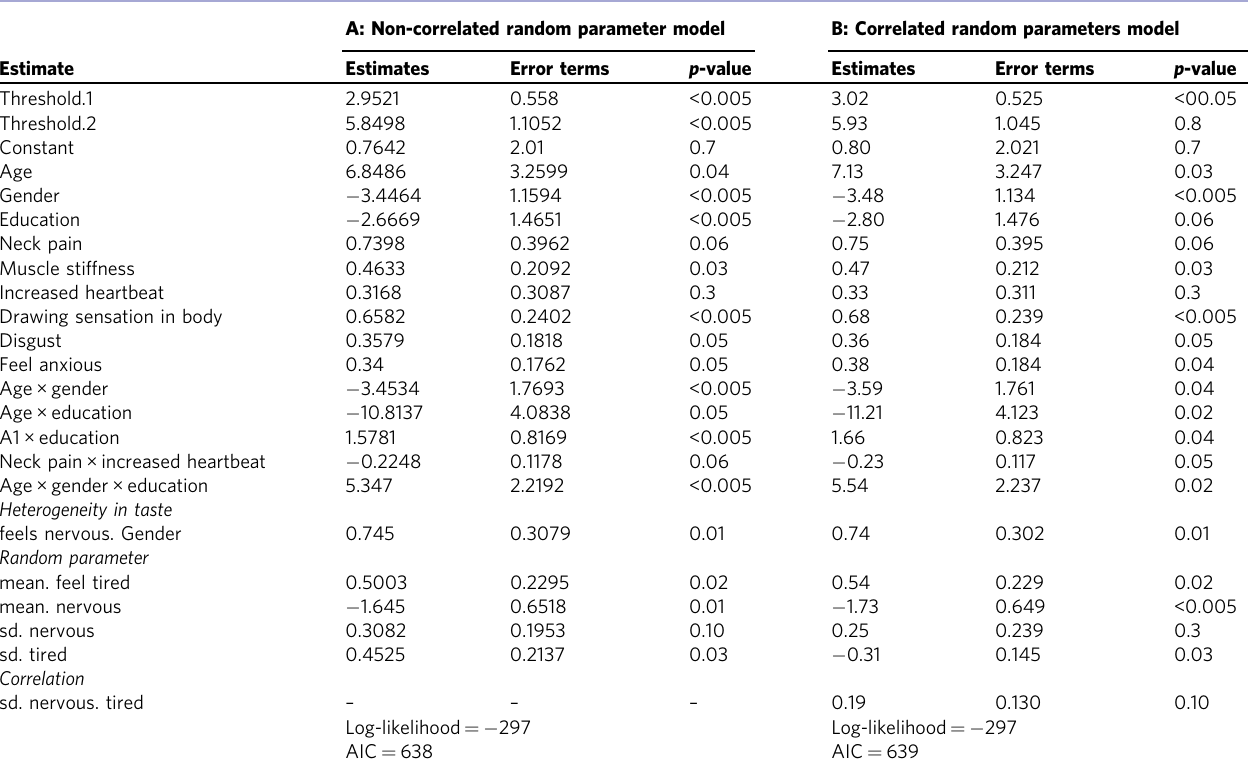
Table 2 Models parameters estimations for perceived quality of the rail transport. A: Non-correlated random parameter model B: Correlated random parameters